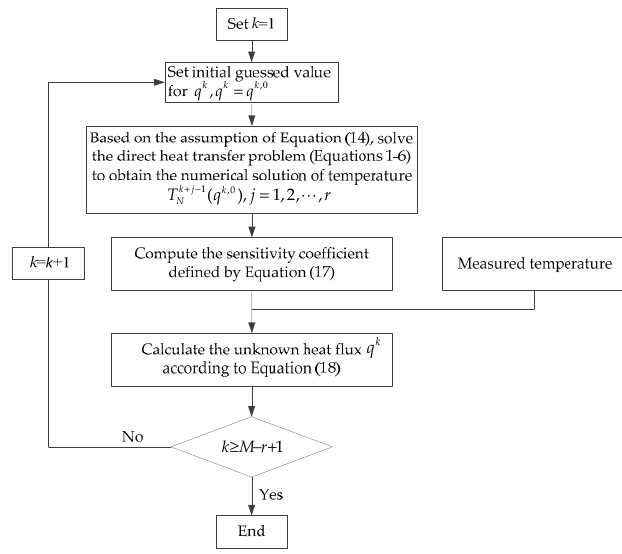
Figure 3. Flowchart of the SFSM algorithm applied for estimating boundary heat flux.